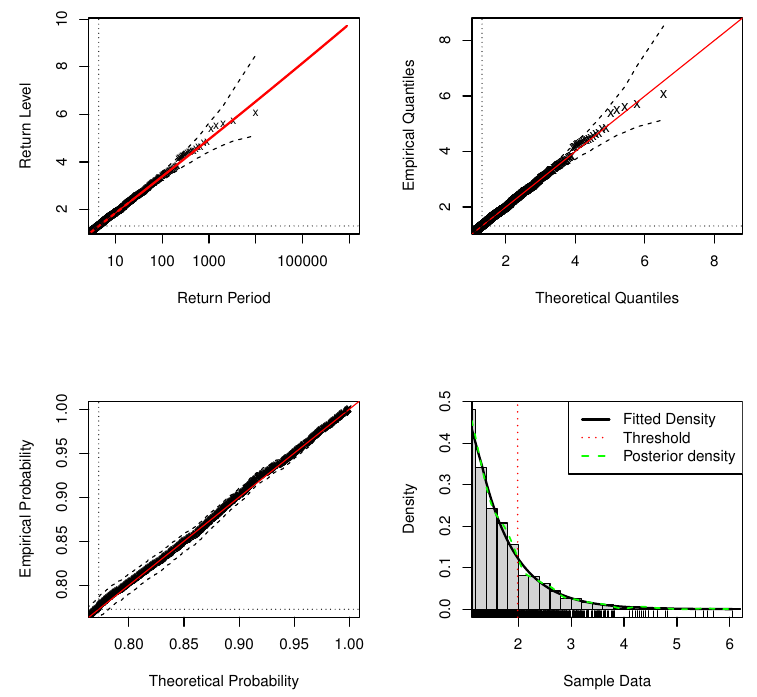
Figure 5. Standard model fit diagnostics for the upper tail of the DPMW-PPR model fitted to the simulated data with n = 5000. (The top left corner is the return level plot, the top right corner is the quantile plot, the bottom left corner is the probability plot, and the bottom right corner is the density plot).